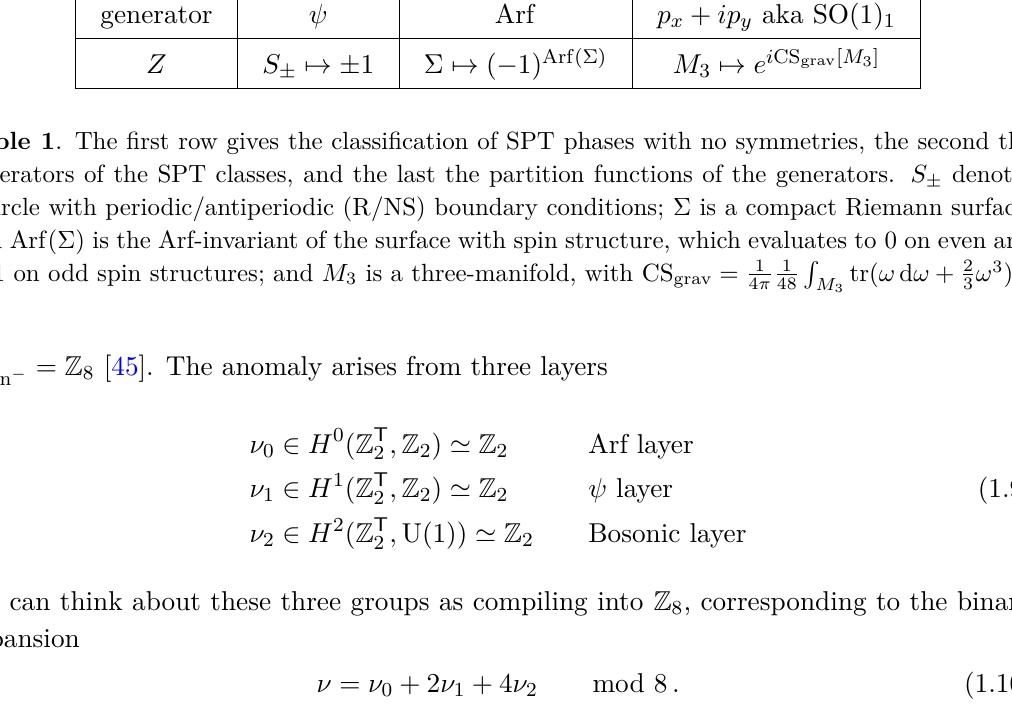
is a three-manifold, with CS 3